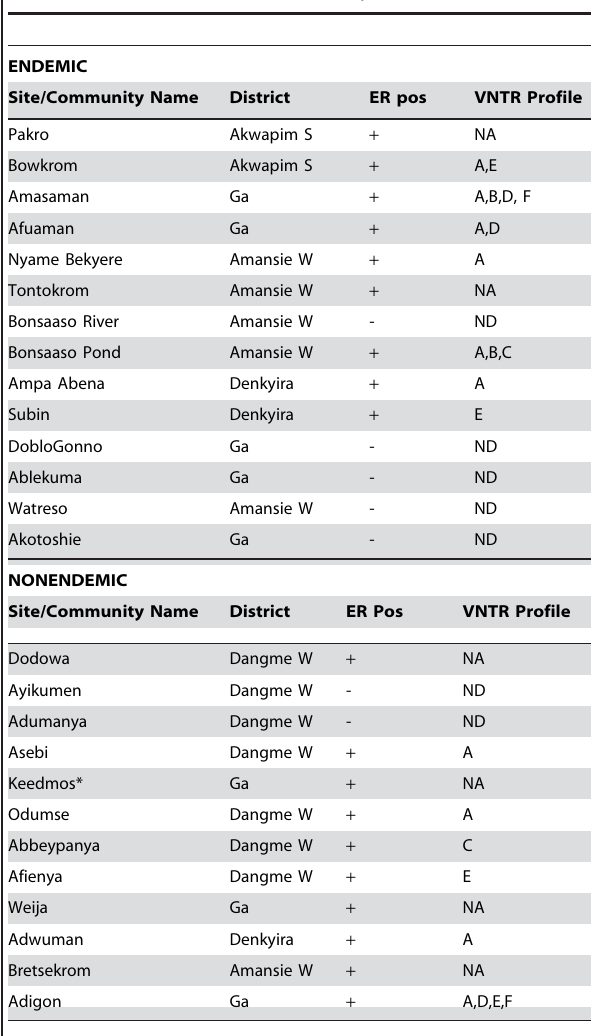
Table 7. ER and VNTR results from all samples obtained from endemic and non-endemic sites sampled.